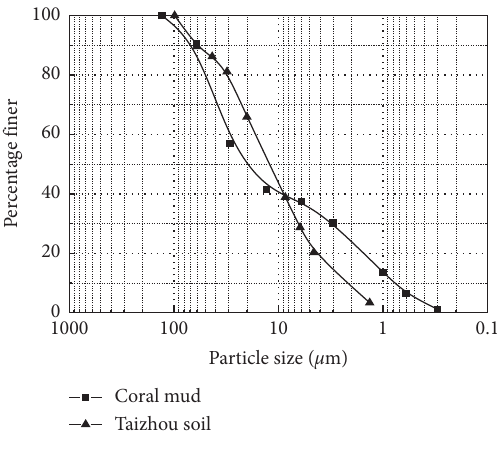
Figure 2: Particle size distribution. Table 2: Basic characteristics of coral mud and Taizhou soil.